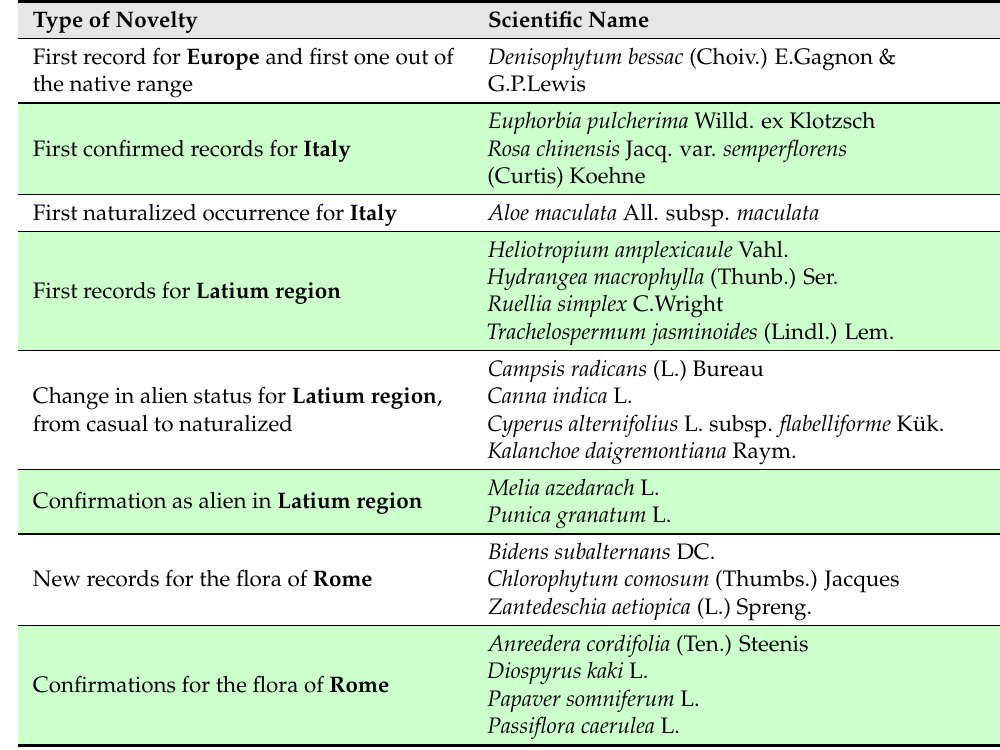
Table 3. Floristic novelties discovered during field surveys. Names are ordered alphabetically per type of